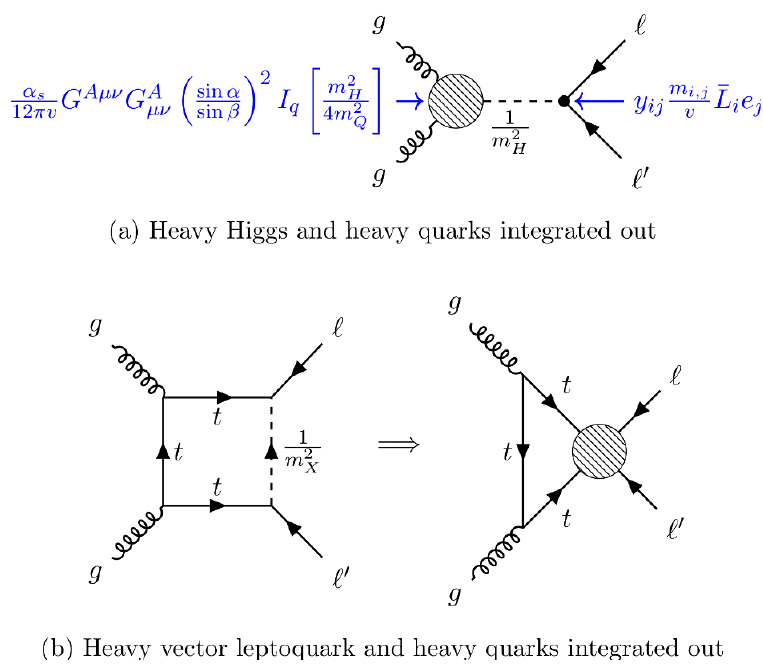
Figure 1 . Examples of UV completions of dimension-8 operators with two gluon (cid:12)eld strength tensors and two